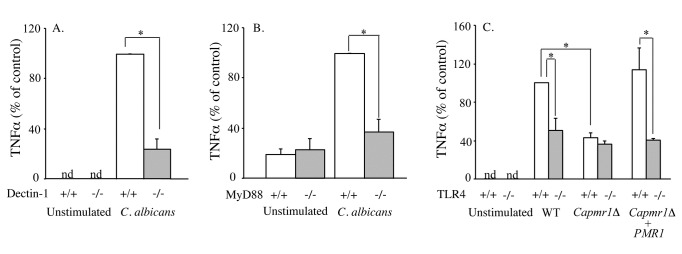
Role of PRRs in regulating C.
albicans-stimulated TNFα
production.Wild type (open bars) and Dectin-1-/- (A), MyD88-/-
(B) and TLR4-/- (C) RPM (shaded bars) were incubated with
C.
albicans for 6 h. In panel C, RPM were
stimulated with the parental wild type C.
albicans (WT), the Capmr1∆
null mutant and the re-integrant strain
(Capmr1∆+CaPMR1). The data are the average of 3
experiments ±S.E. (*p<0.05). Levels of TNFα in the culture medium
were determined by ELISA.